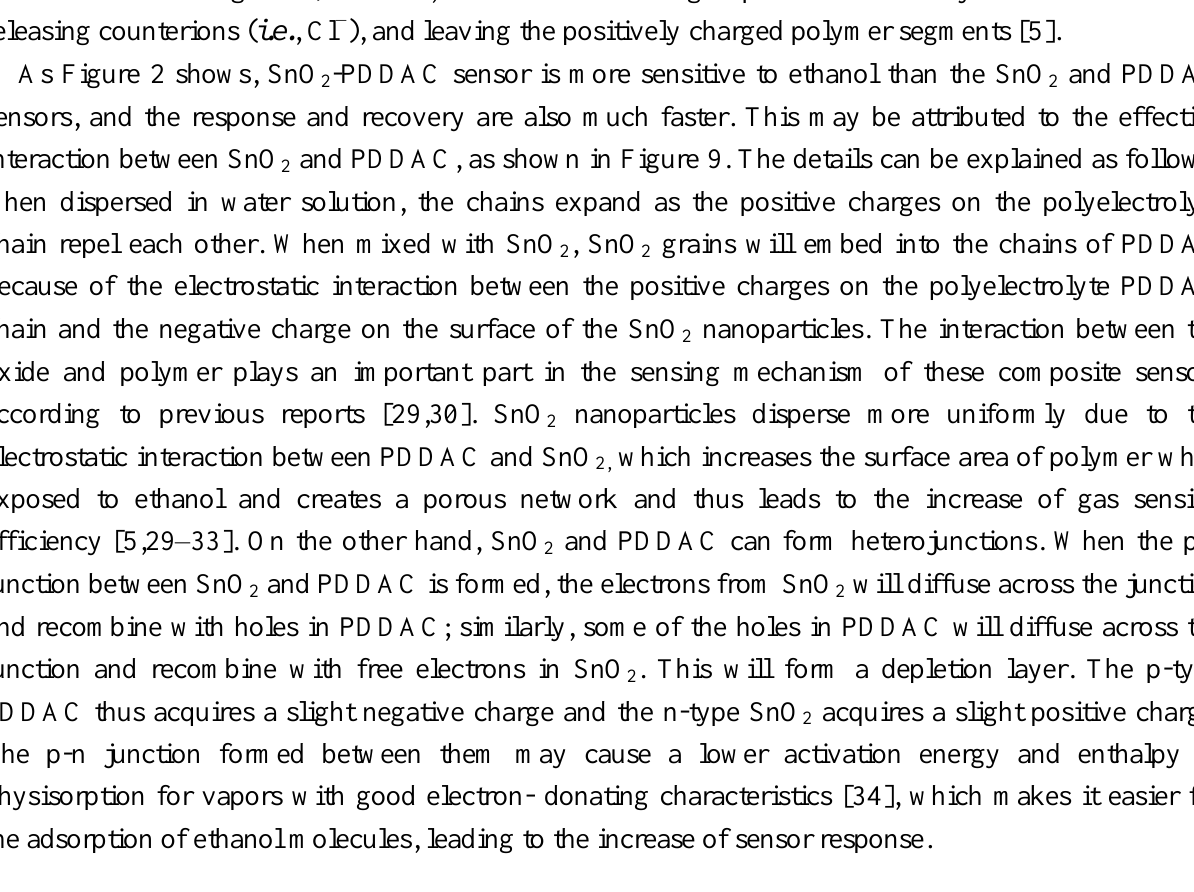
Figure 10. The response of the SnO